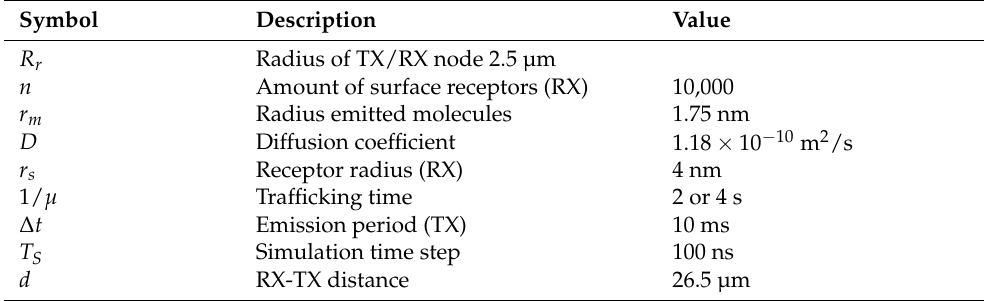
Table 1. Simulation